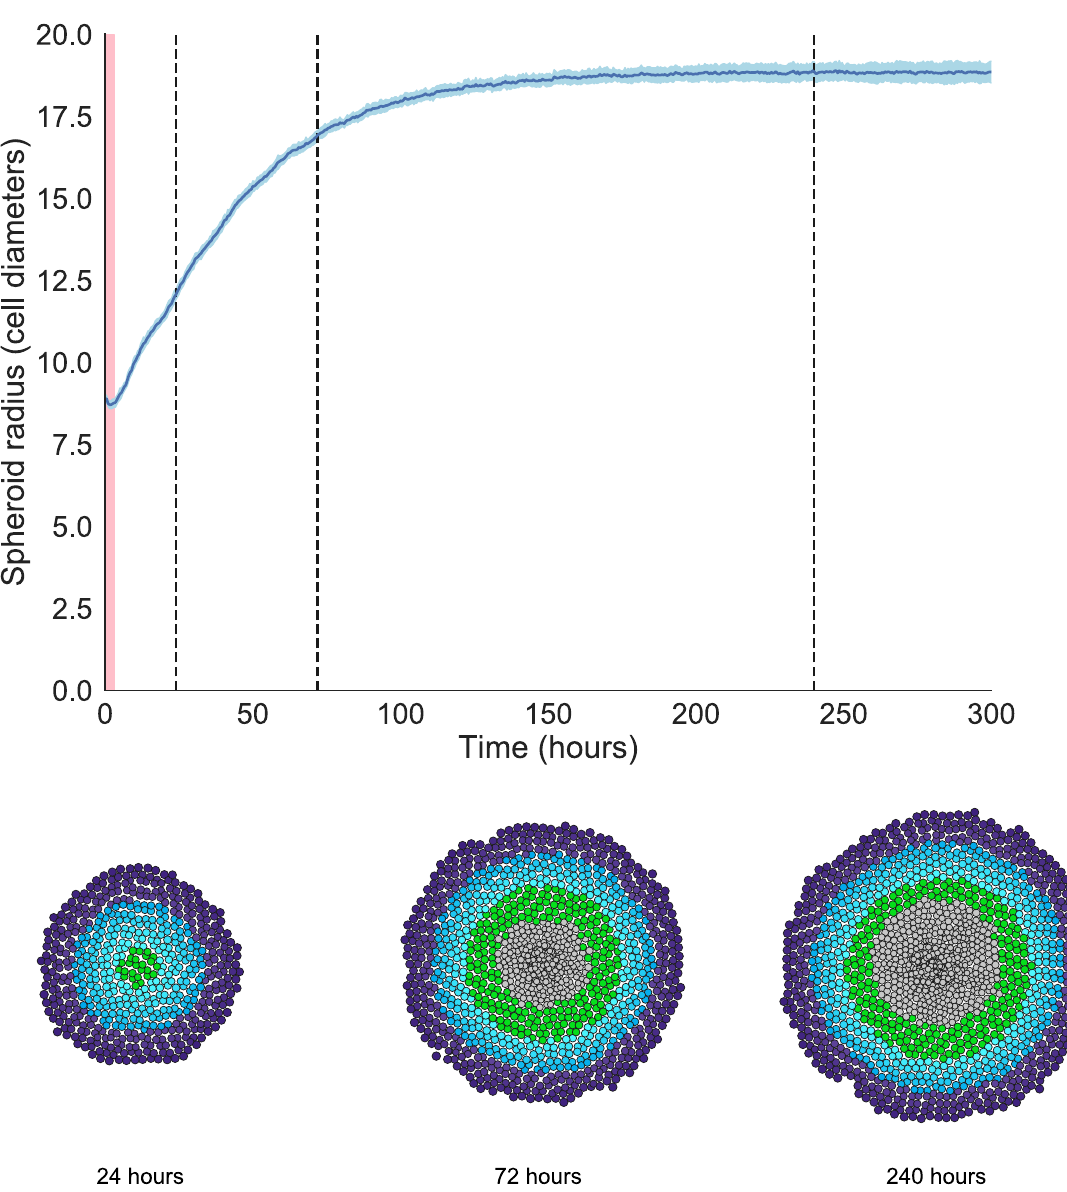
Fig 2. Model validation I: reproducing spheroid growth dynamics. A: Saturating growth curve for one representative parameter set (Parameters: ω q = 0.5, ω h = 0.3, τ = 16, ~ t ¼ 8 ) showing total spheroid radius over time (mean and standard deviation of 40 realisations). The spheroid radius decreases during an initial burn in period as cells relax from their initial positions to form a densely packed cluster of cells, highlighted in red ( t = 0 to t = 4). After this burn in period, the simulations show initial rapid growth followed by growth saturation when spheroid size is sufficiently large. B: Simulation snapshots showing the spheroid composition after 24, 72 and 240 hours for the parameter set in A. Times of snapshots are marked with a dashed line in A. During the rapid growth phase the spheroid consists primarily of proliferative and quiescent cells, and the reduction in spheroid growth rate is associated with the formation of the necrotic core. densely packed spheroid. Thereafter the tumour radius grows rapidly, slowing when nutrient levels at its centre become too low to support cell proliferation, and saturating when the rate at which nutrient-rich cells proliferate balances the rate at which necrotic cells are degraded [3]. For the parameter values chosen here, the tumour reached its steady state approximately 150